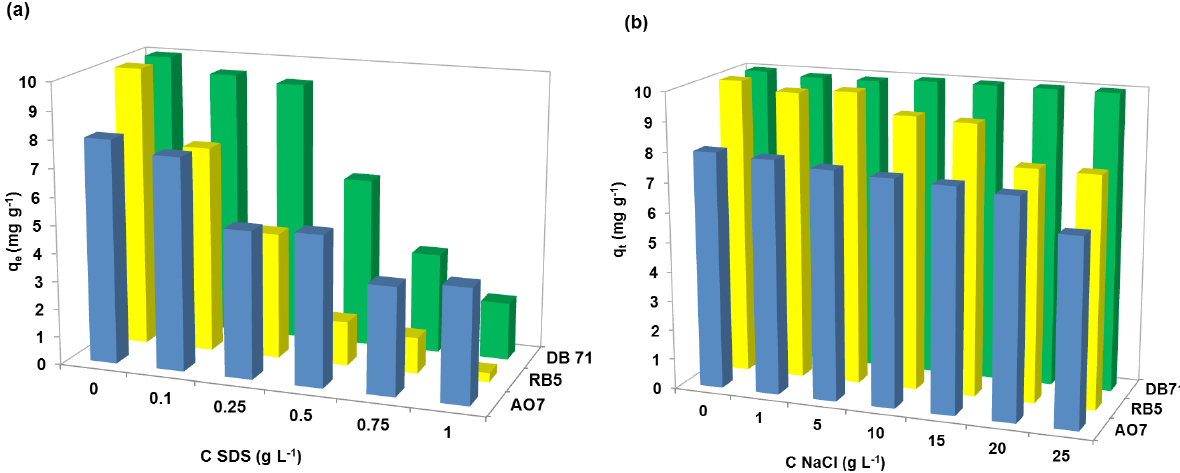
Figure 7. Effect of SDS (a) and NaCl (b) addition on the dyes sorption at equilibrium by the aminosilane modified silica ( conditions: initial dyes concentration: 100 mg L -1 , volume: 50 mL, sorbent mass: 0.5 g, agitation speed: 180 rpm, temperature: 25 o C, phase contact time: 60